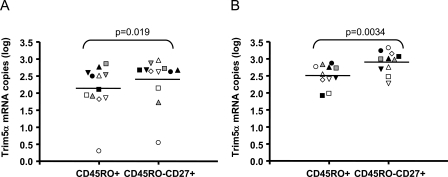
Analysis of Trim5α mRNA Levels in Naïve and Memory CD4 T Cells(A) Trim5α mRNA levels in naïve CD4 T cells (CD45RO-CD27+) and memory CD4 T cells (CD45RO+) obtained from healthy controls.(B) Average Trim5α mRNA levels in naïve and memory CD4 T cells during the course of infection from HIV-1 infected individuals. Trim5α mRNA levels are normalized for β-actin mRNA levels. Different symbols represent Trim5α mRNA levels of naïve and memory CD4 T cells from the different individuals.